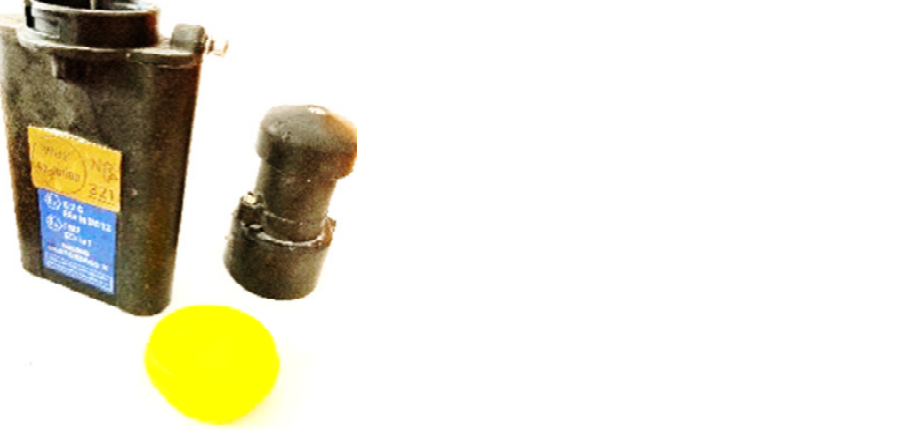
Figure 3. Arrangement of devices in the gateroad. PM4 dust concentration was measured with the use of CIP-10R dust meters (Figure 4). Measurements of dust weight in the measuring cups of personal dust meters were per- formed by a body accredited in the scope of tests in the work environment. Measurements were taken in five coal faces and four gates.